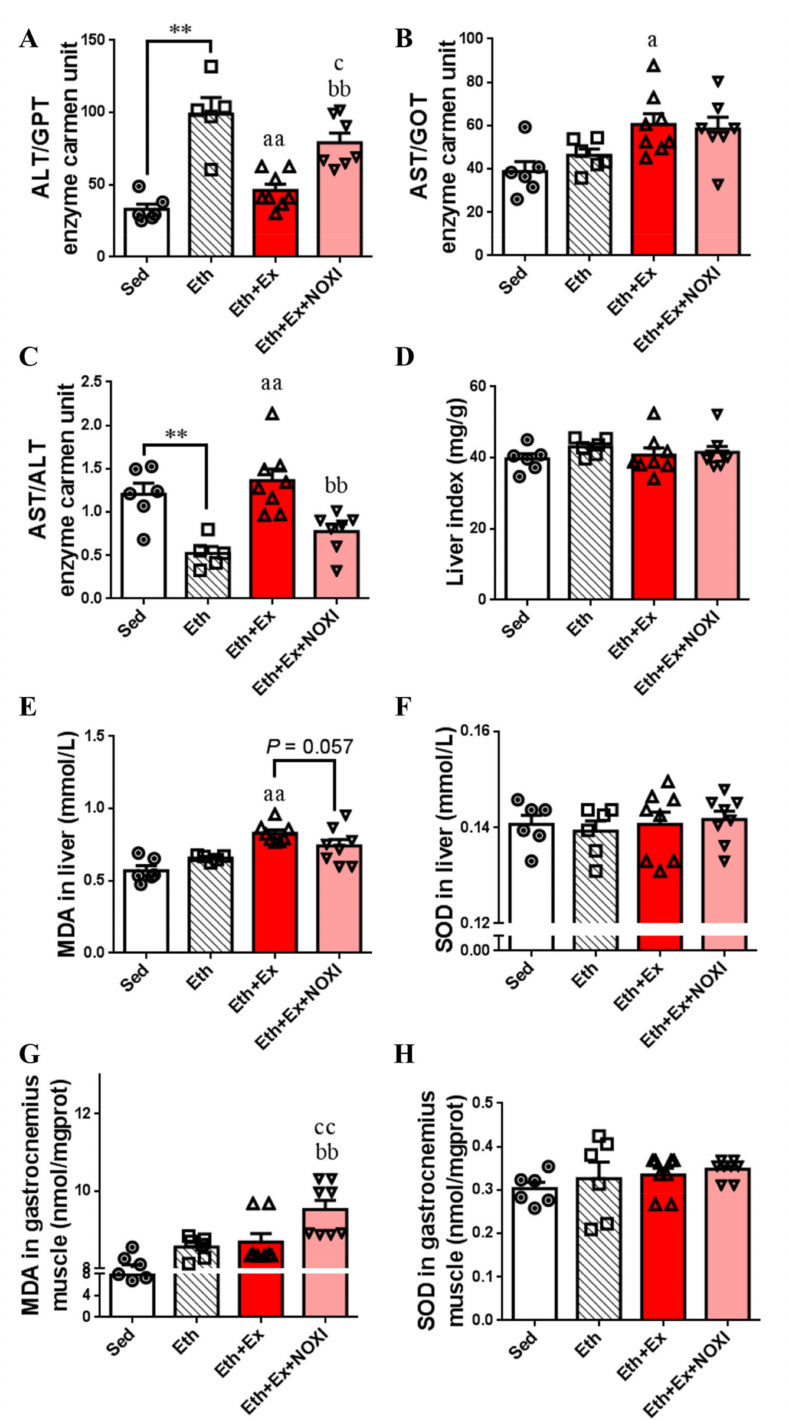
Figure 5. Exercise during drinking can increase levels of inflammation and aggravate the oxidative response of liver and skeletal muscle tissues. ( A ) The level of ALT in serum. ( B ) The level of AST in serum. ( C ) Serum AST/ALT values. ( D ) The level index. ( E , F ) MDA and SOD levels in liver tissue. ( G , H ) MDA and SOD levels in gastrocnemius muscle tissue. ( A – H ) The molding effect is represented by *, ** p < 0.01. The exercise effect is denoted by a, a p < 0.05 and aa p < 0.01. The drug effect is denoted by b, bb p < 0.01. The effect of combined exercise and drug intervention is indicated by c, c p < 0.05 and cc p <